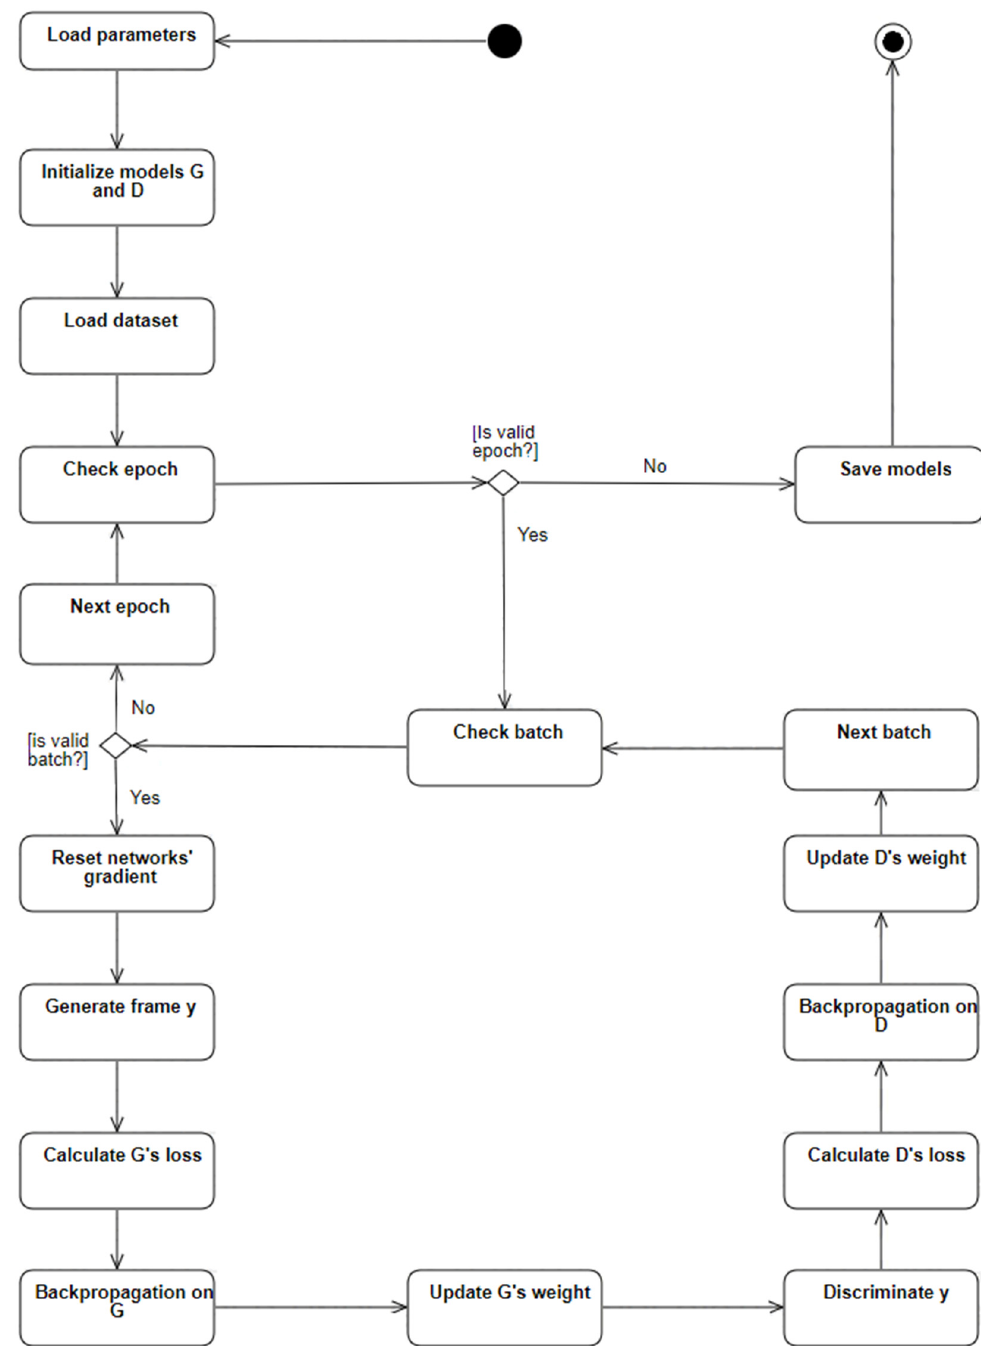
Figure A2. The activity diagram of the training process of the proposed frame interpolation network.